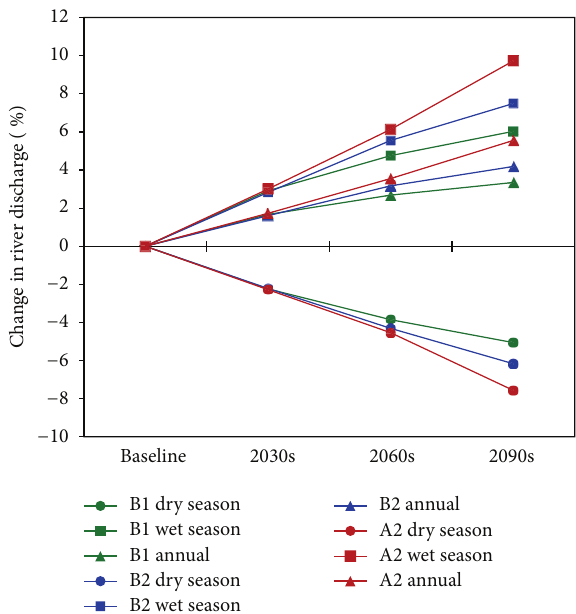
Figure 10: Change in seasonal and annual river discharge at Yen Thuong